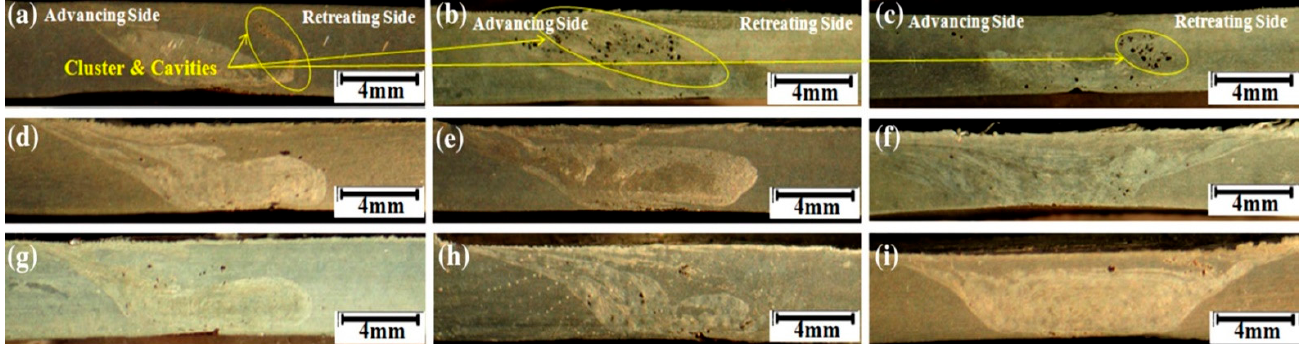
Figure 18. Cross-section of joints obtained at: ( a ) 800 rpm-F pass; ( b ) 800 rpm-2F passes; ( c ) 800 rpm- FB passes; ( d ) 1000 rpm-F pass; ( e ) 1000 rpm-2F passes; ( f ) 1000 rpm-FB passes; ( g ) 1200 rpm-F pass; ( h ) 1200 rpm-2F passes; ( i ) 1200 rpm-FB passes [56]. Reprinted from: The effect of Cu powder